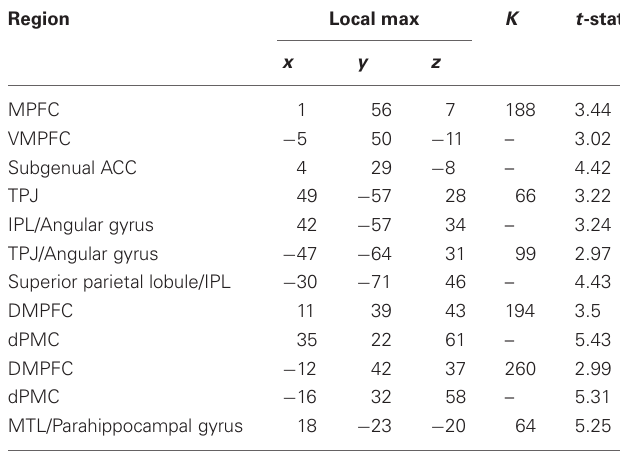
Table 3C | Positive correlations with enthusiasm, as rated by human